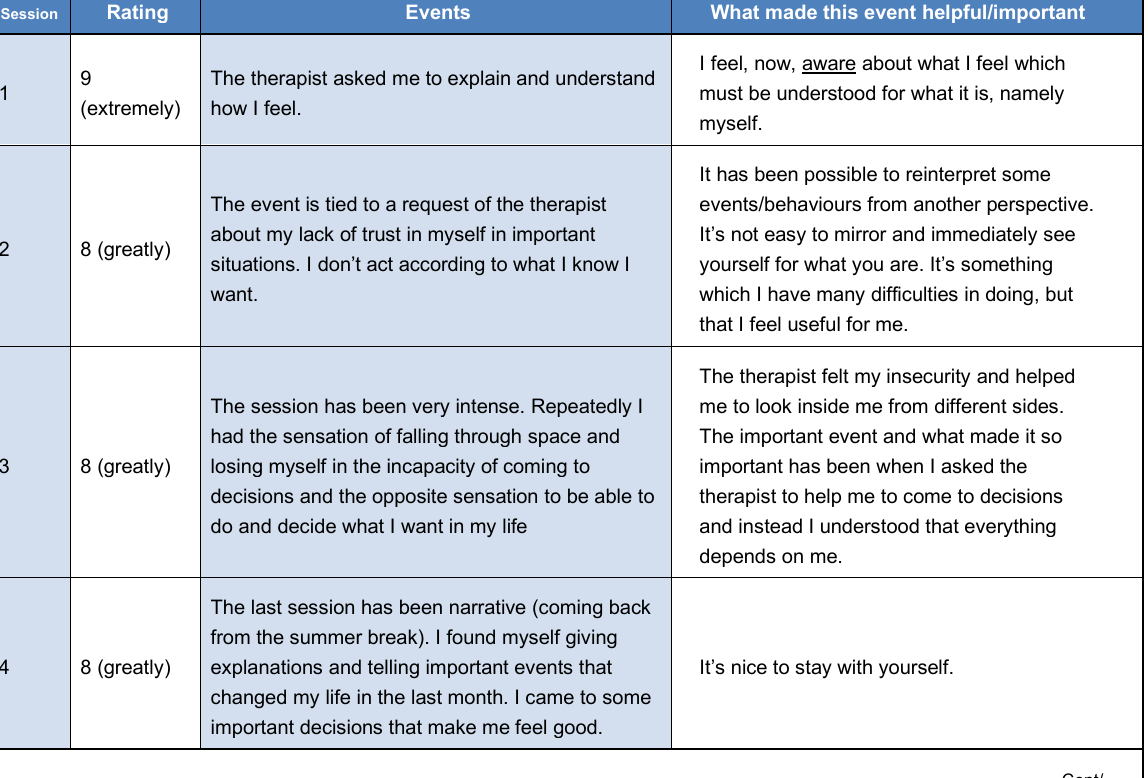
Session Rating Events